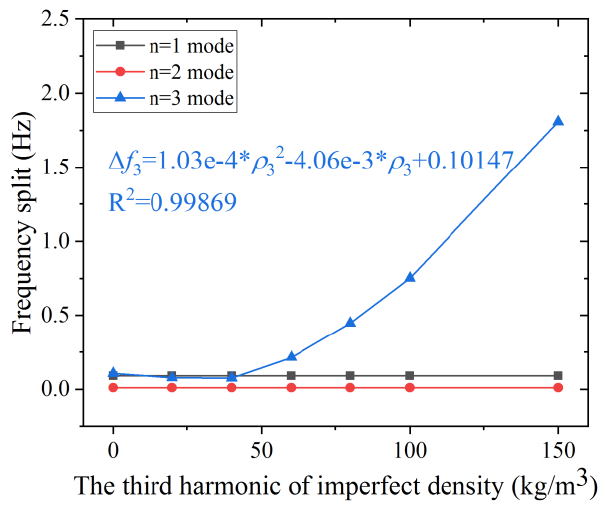
Figure 6. The effect of ρ 3 on the frequency split of the n = 1, 2, and 3 modes.